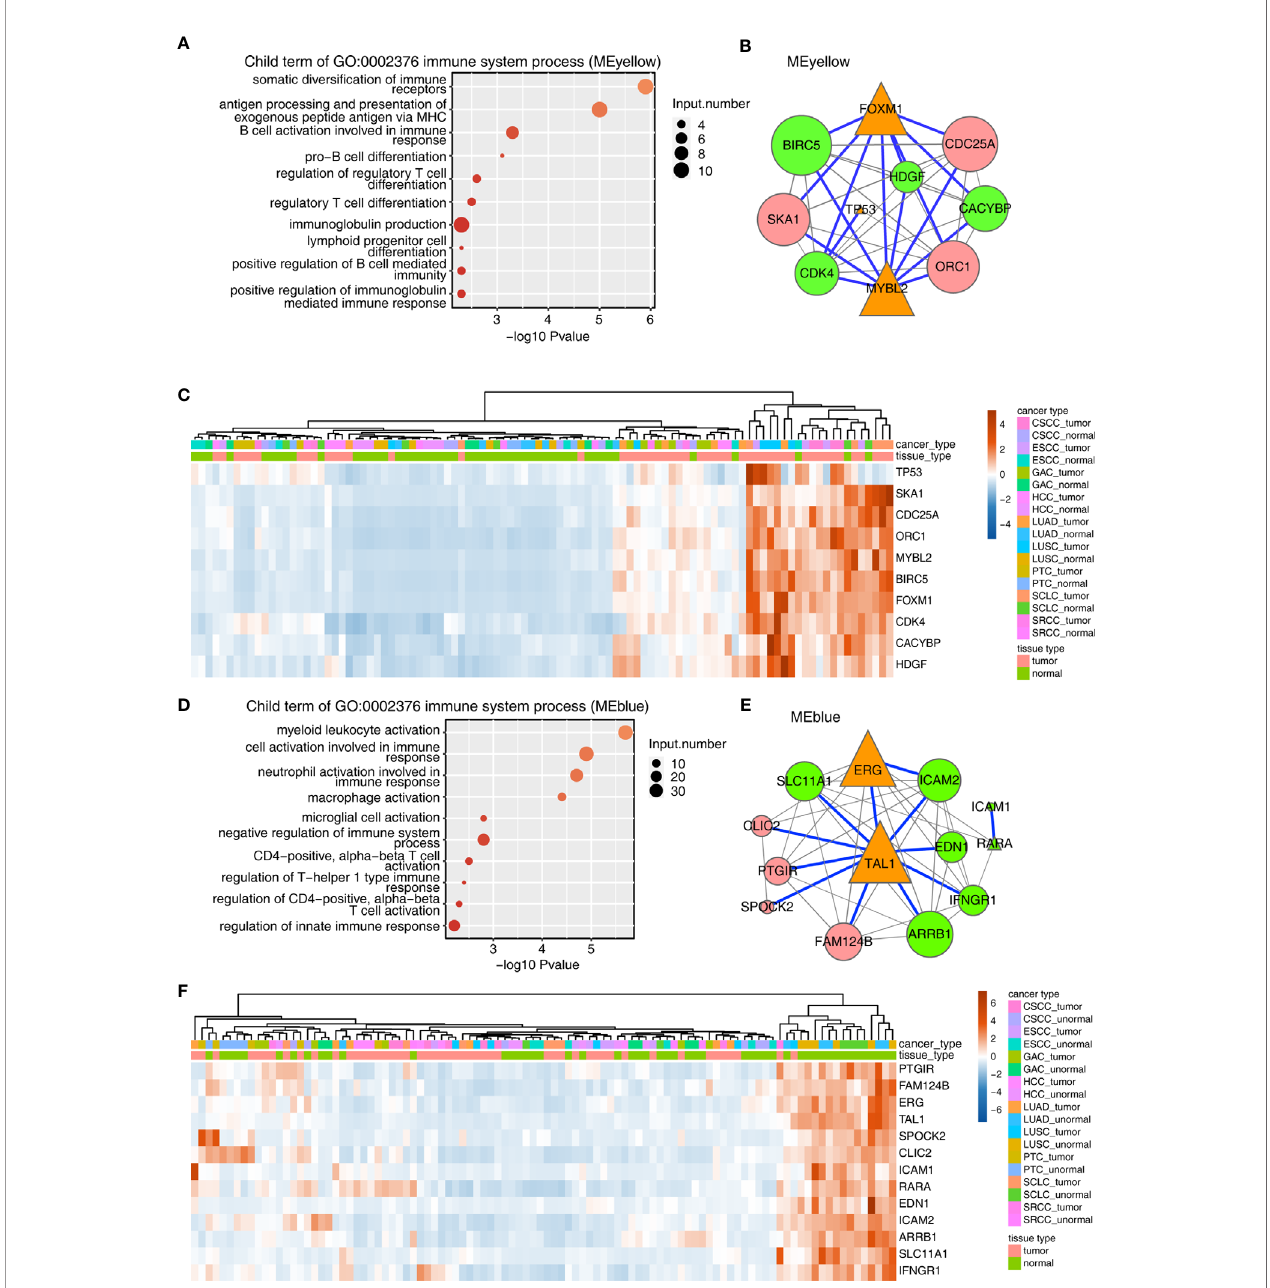
FIGURE 2 | Construction of the TF – immune-related gene expression network in MEyellow and MEblue modules. (A) Metascape analysis was performed to cluster the tumor-associated genes in the MEyellow module. The parent GO term of the immune system process pathway was enriched, and its child GO terms were extracted and presented. (A) TF – immune-related gene expression network of the tumor-associated DEGs clustered in the MEyellow module. The expression levels of TF genes, LM22 marker genes, and immune-related genes were fi ltered. Then, we calculated the Spearman correlation for each gene pair. Gene pairs with Spearman correlation coef fi cients >0.6 (or less than − 0.6) and a corresponding p value (Benjamini – Hochberg corrected) <0.01 were considered signi fi cantly correlated. Then, the TF – immune gene pair or TF – LM22 gene pair was fi ltered when the TF – gene pair was found in the Encode TF target database or the TRRUST database. The TF – immune-related gene expression network was built with Cytoscape in which the triangle represented TF, the green represented immune genes, and the red represented LM22 marker genes. Speci fi cally, the connection of TF – immune-related genes with database support were illustrated with blue lines. Orange triangles indicated TF genes, green circles indicated immune-related genes, and pink circles indicated LM22 genes. Node size indicated the number of correlated genes in the gene network. (A) Expression pro fi le of genes involved in TF – immune-related genes in (B) . (D – F) Same as 0 (A – C) , except that tumor-associated DEGs from the MEblue module were